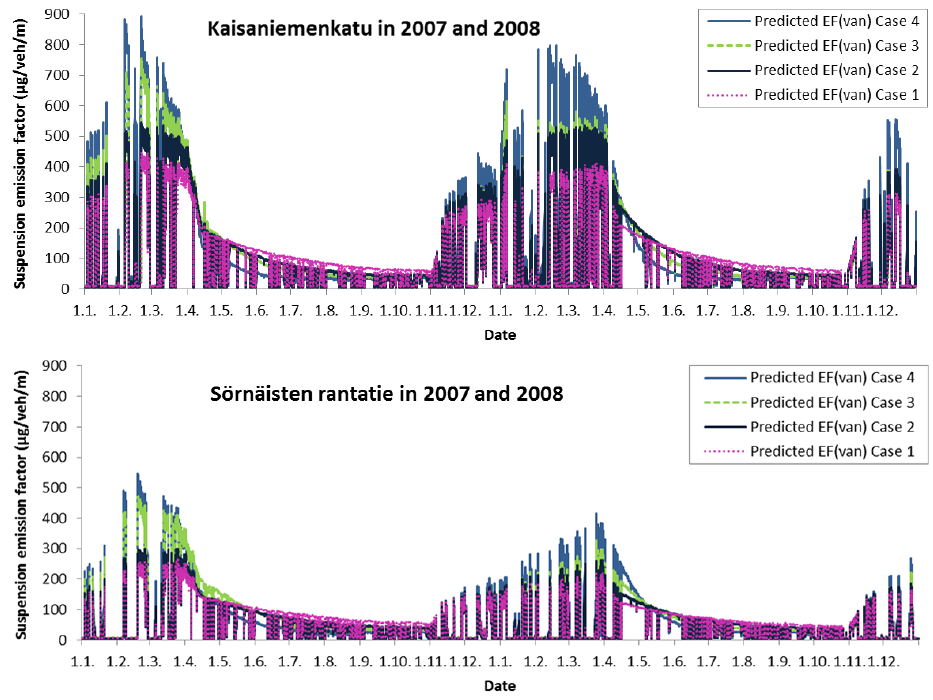
Figure 4. Hourly average suspension emission factors predicted by the NORTRIP model in Kaisaniemenkatu (upper panel) and in Sörnäisten rantatie (lower panel) in 2007 and 2008, for four sensitivity analysis cases (defined in Table 3).